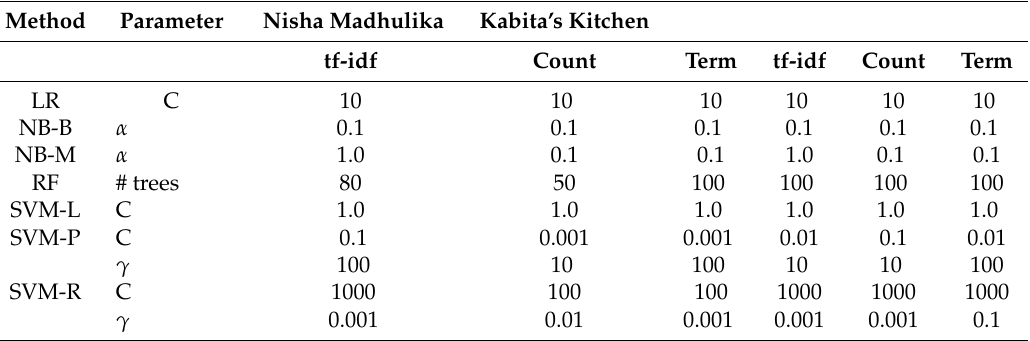
Table 5. Parameters chart.